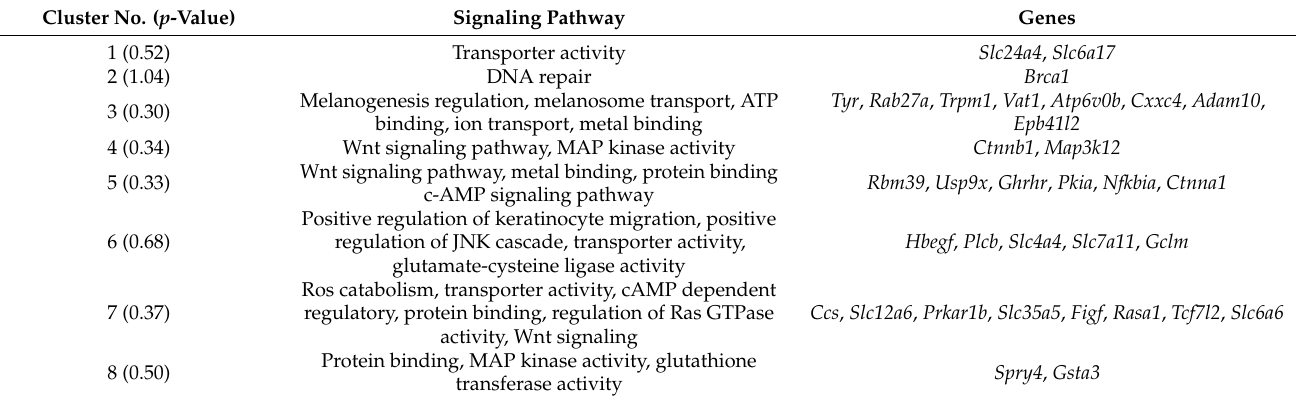
Table 2. Gene clusters obtained by hierarchical clustering of significantly expressed genes in APC-treated B16 cells a,b . Cluster No. ( p